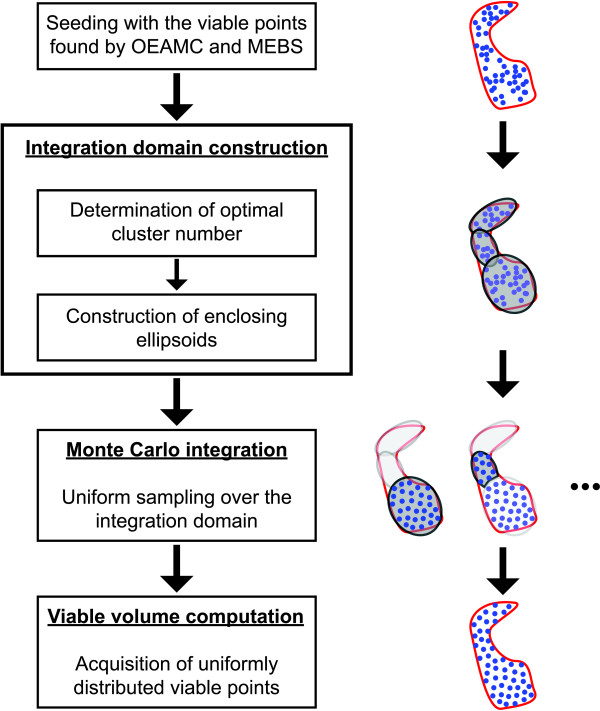
Flowchart representing the algorithm for viable volume estimation, and the acquisition of a set of viable parameter points. A set of viable parameter points found by OEAMC and MEBS (uppermost set of blue points in the figure) which are nonuniformly distributed over the whole viable space (area covered by the red curve in the figure) seeds the algorithm. Then, the method groups these points into k clusters (k = 3 in the hypothetical example shown), and calculates the ellipsoids with minimum volume that enclose the points in each cluster (11). After that, the algorithm performs a Monte Carlo integration of every ellipsoid (the intersections between ellipsoids are sampled only once) (12, 13). The result of the algorithm is a set of uniformly distributed viable parameter points (bottom set of blue points in the figure), from which the viable volume can be estimated.